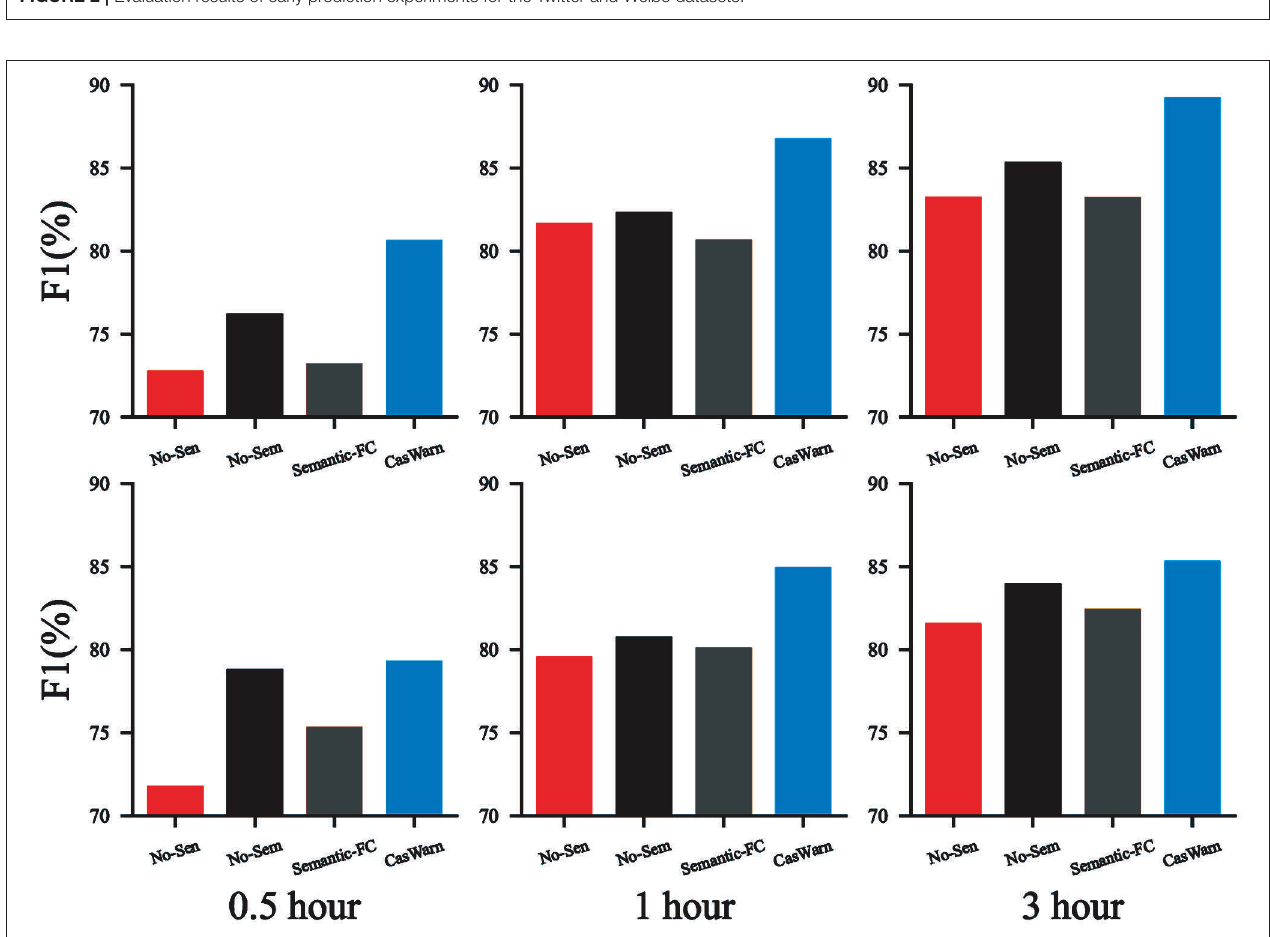
FIGURE 3 | Performances of variant proposed